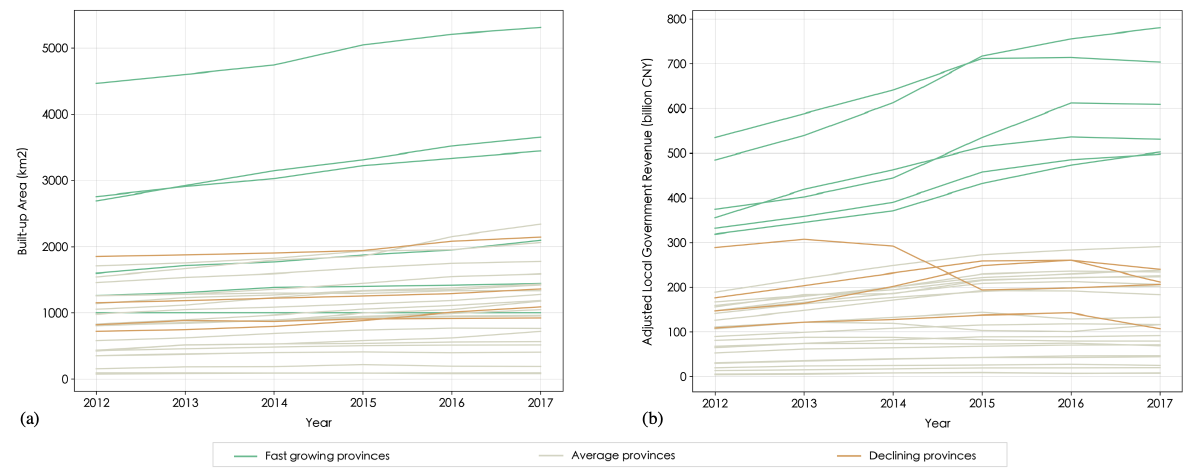
Figure 1. (a) Change of built-up area in China from 2012-2017; (b) Change of local government revenue in China from 2012-2017 (constant price based on year 2012 level; data source: China City Statistical Yearbook